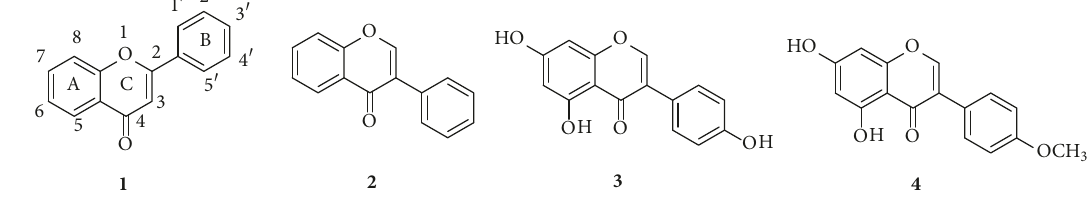
Figure 1: Structure of flavonoid (1), isoflavonoid (2), genistein (3), and biochanin A (4).